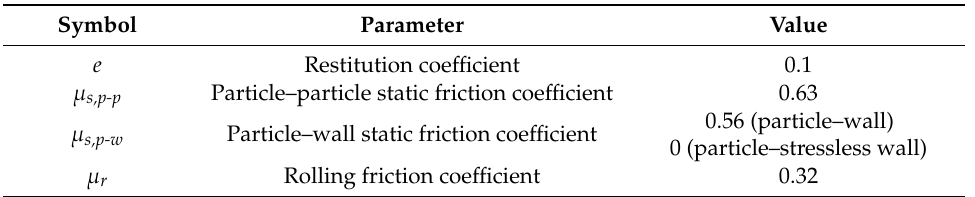
Table 1. Parameters used in the simulation.